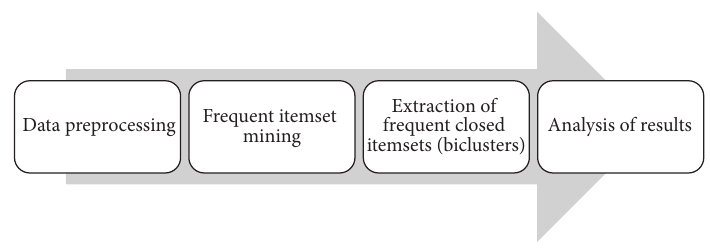
Figure 3: Schematic view of frequent closed itemset